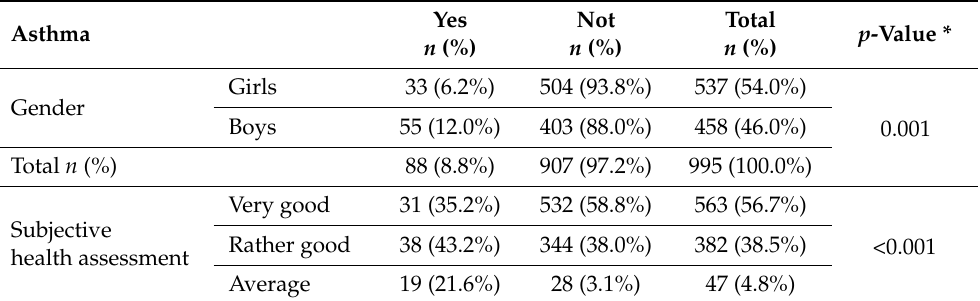
Table 1. Asthma diagnosis versus gender and subjective health assessment of